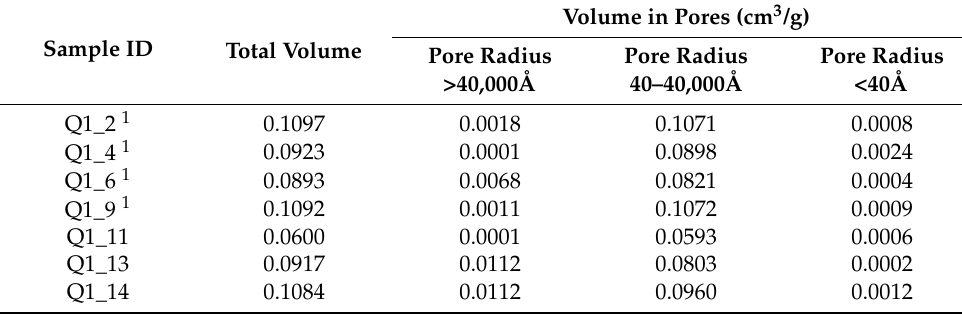
Table 6. Interpolated mercury intrusion pore radius.